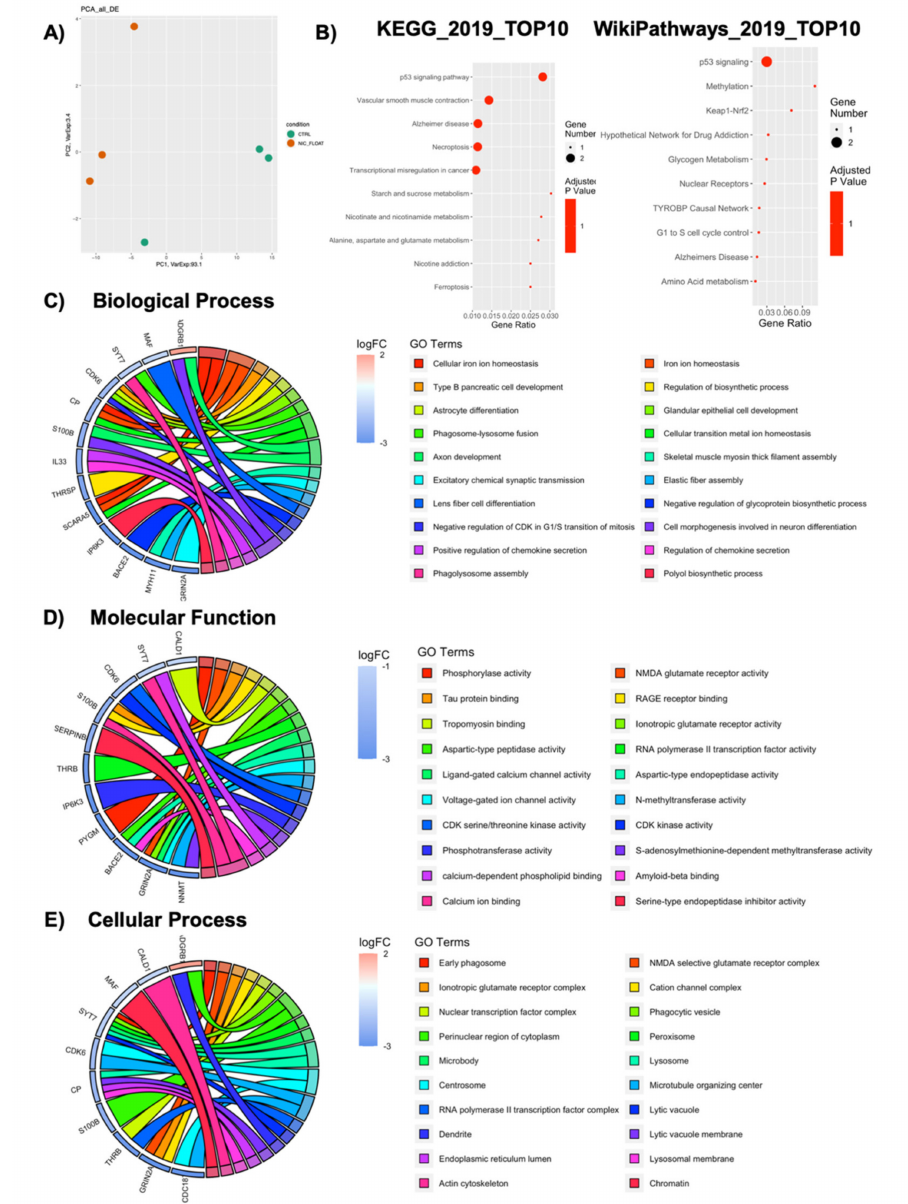
Figure 9. Computational analysis of neural precursor Cells detached from the Nichoid and brought back to standard floating conditions for 7 days. RNA-Seq was performed on three samples for condition ( n = 3). Specifically, three experiments were performed each including one sample of NPCs grown in standard floating conditions for 7 days and one sample of NPCs grown inside the Nichoid and replated in standard floating condition for 7 more days. ( A ) Principal component analysis (PCA) of di ff erently expressed genes in NPCs replated after Nichoid-growth and in standard conditions. We considered as di ff erentially expressed only genes showing | log 2 (Nichoid samples / control samples) | ≥ 1 and a false discovery rate of ≤ 0.1. ( B ) Pathway analysis for DE genes in NPCs replated after Nichoid-growth to NPCs grown in standard conditions. The y-axis represents the name of the pathway, the x-axis represents the gene ratio, dot size represents the number of di ff erent genes, and the color indicates the adjusted p -value. Dot plot of top 10 deregulated pathways from KEGG and WikiPathways analysis. ( C – E ) GO analysis for DE genes in NPCs replated after Nichoid-growth compared to NPCs grown in standard conditions. ( C ) Top 20 enriched GO terms for Biological Process, ( D ) Molecular Function, and ( E ) Cellular Component are shown. The panels have been obtained considering all DE genes, and the color represents di ff erent pathways implicated to the deregulated